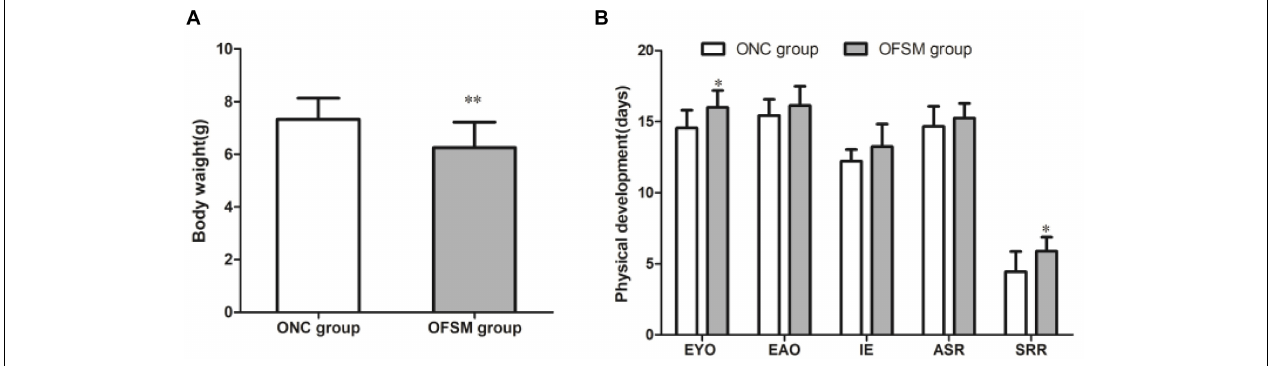
FIGURE 3 | Fear stress in pregnant rats during gestational days may affect the physical and the reflex development of offspring. (A) Birth weights of offspring. ONC group ( n = 125) and OFSM group ( n = 129). (B) Physical and reflex development of offspring. OFSM, offspring from the FSM group ( n = 12); ONC, offspring from the normal control group ( n = 10); EYO, eye opening; EAO, ear opening; IE, incisor eruption; ASR, auditory startle reflex; SRR, surface righting reflex. Values are expressed as means ± standard deviations. * P < 0.05 and ** P < 0.01 versus the ONC group.